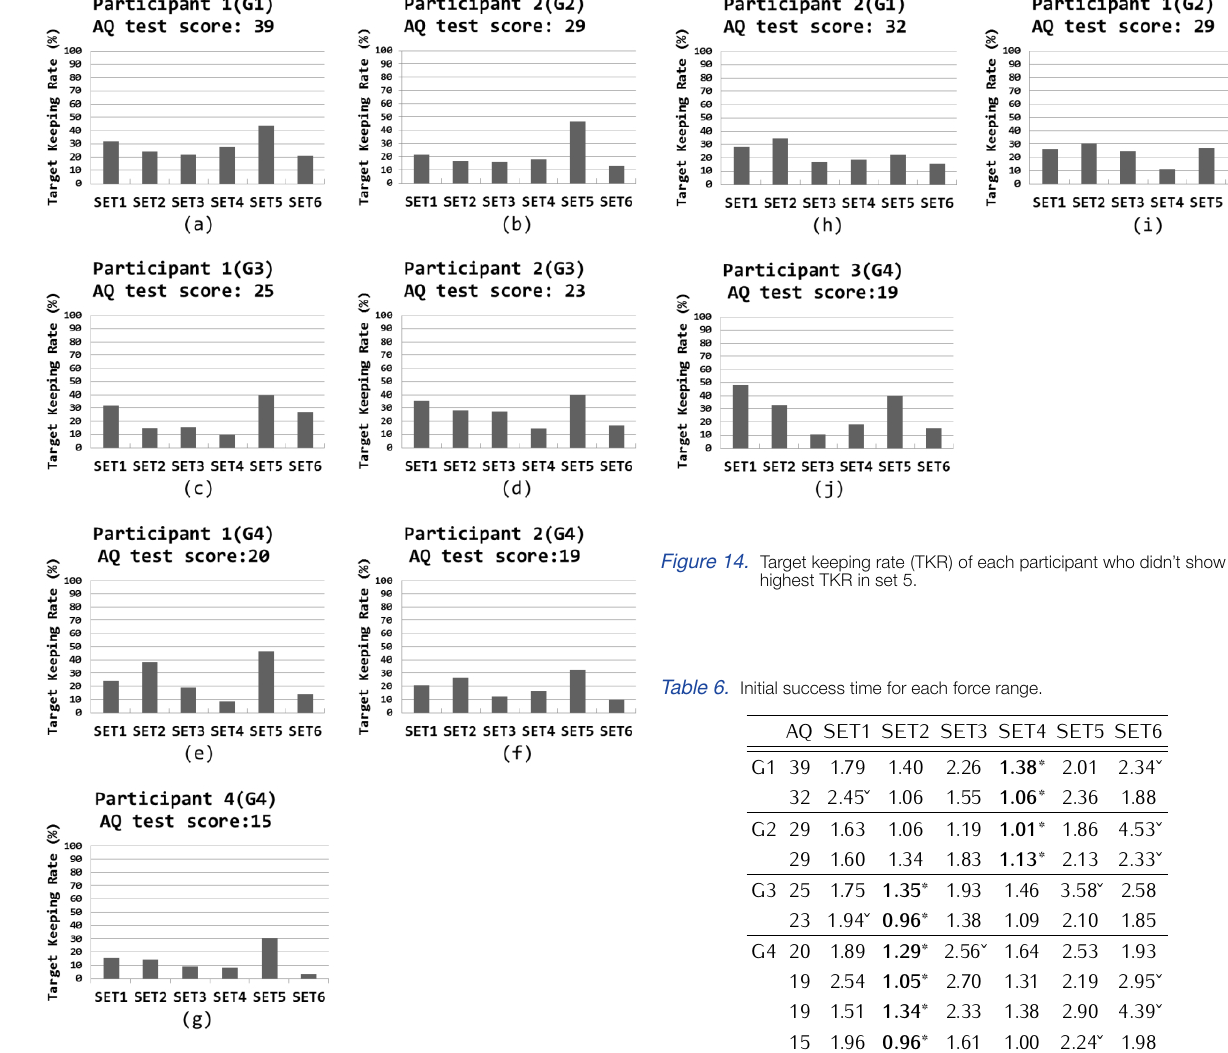
Figure 13. Target keeping rate (TKR) of each participant who showed highest TKR in set 5.